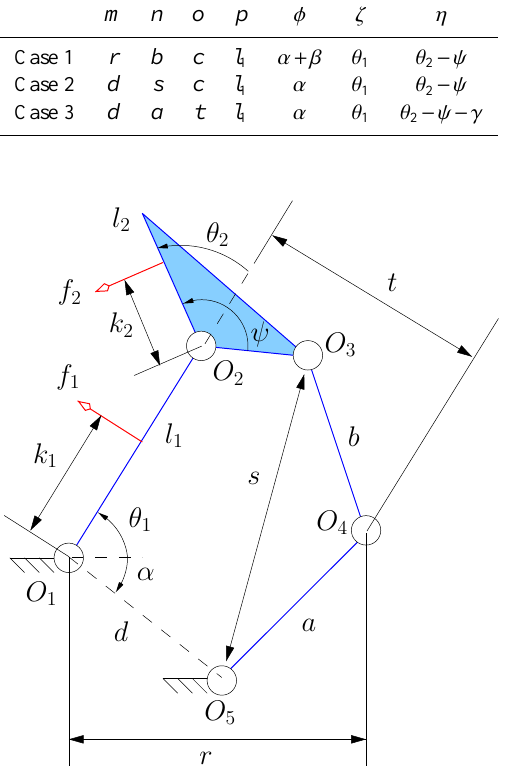
Figure 5. Details of the class S two-phalanx